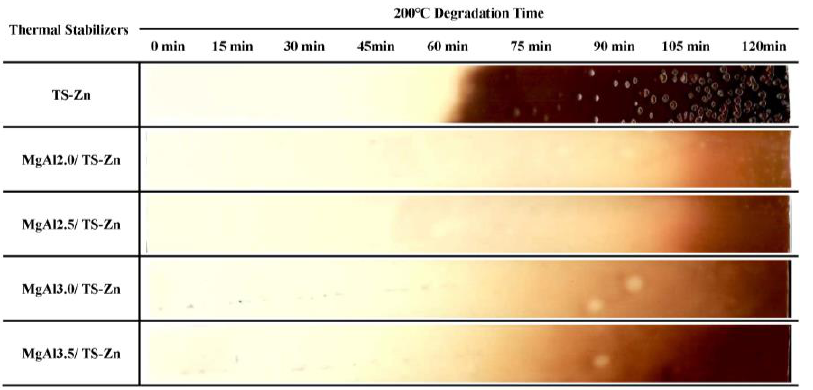
Figure 8. The XRD pattern of MgAl2.0 and its crosslinked counterpart (CL-MgAl2.0). The desorption peak temperature of MgAl2.0 was 20°C lower than that of crosslinked CL-MgAl2.0, while the peak area of MgAl2.0 was much larger than that of its crosslinked counterpart (Figure 9 and Table 3). This suggests that crosslinking has increased the strength of the basicity and reduced the surface basicity of the LDHs.